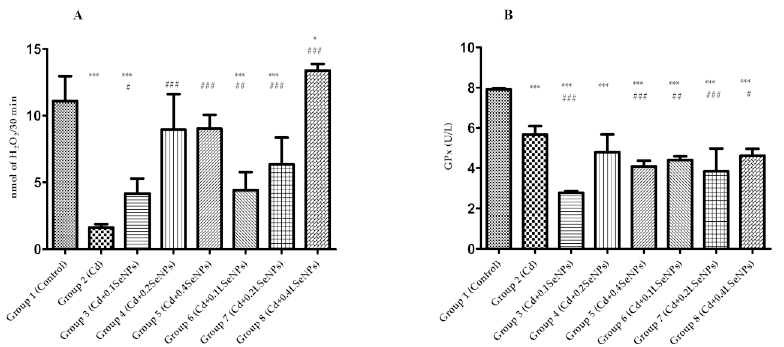
Figure 3. Effects of cadmium and selenium on catalase ( A ) and GPx ( B ) after 30 days of treatment. All values were expressed as the mean ± SD for 10 mice in each group. SeNPs+Cd and LSeNPs+Cd at different concentrations vs. control group: * p < 0.05; *** p < 0.001. SeNPs+Cd and LSeNPs+Cd at a different concentration vs. the cadmium group: # p < 0.05; ## p < 0.01; ### p < 0.001. Groups: 1—control; 2—CdCl 2 ; 3—CdCl 2 + 0.1 mg/kg SeNPs; 4—CdCl 2 + 0.2 mg/kg SeNPs; 5—CdCl 2